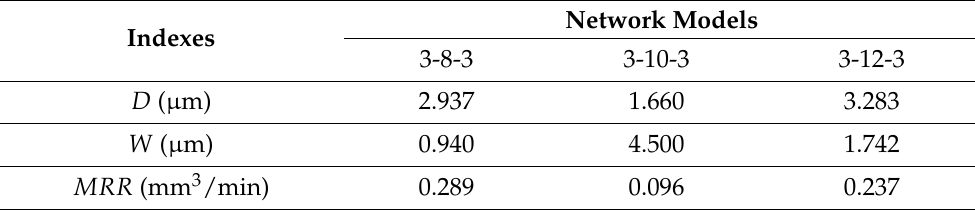
Table 9. RMSEs of testing set